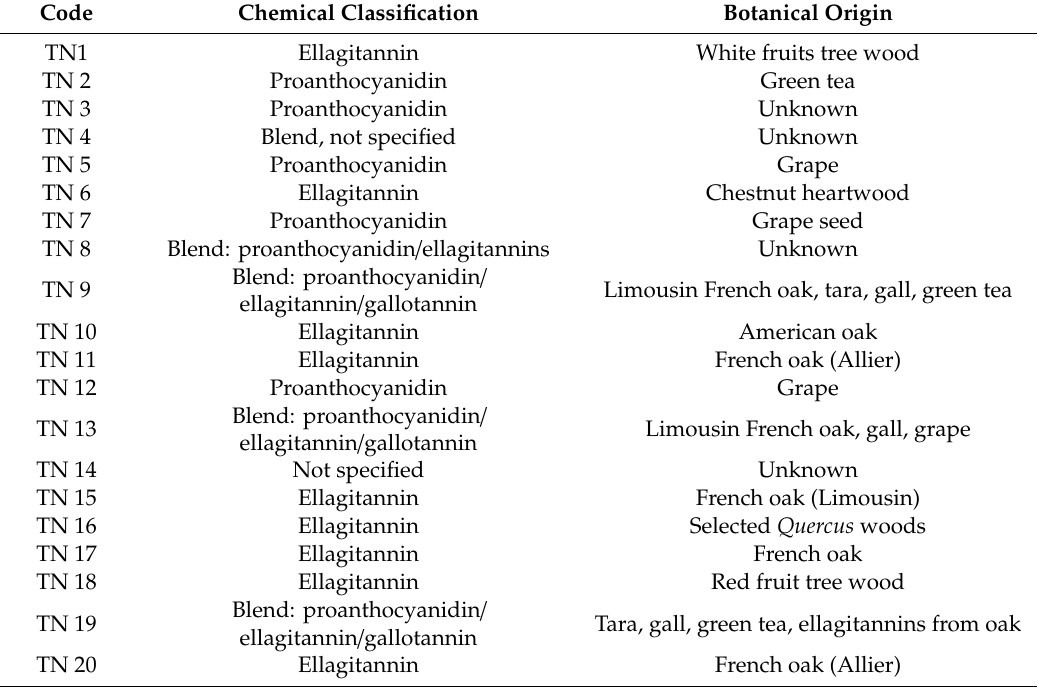
Table 4. Commercial oenological tannins selected for this work with the generic compositional information provided by suppliers. The classification as “Blend “refers to the mixture of tannins from di ff erent botanical sources as described in the commercial